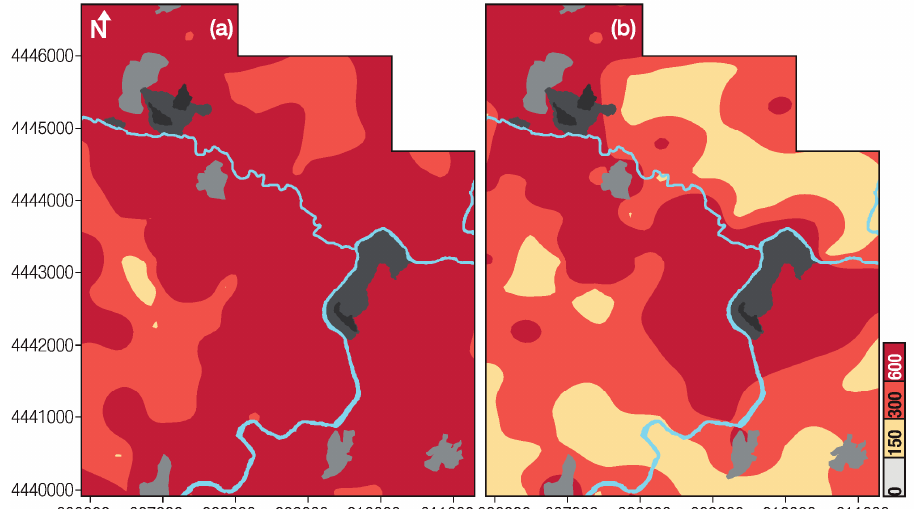
Figure 6. Spatial distribution of Potential Ecological Risk Index ( PERI ) for topsoil ( a ) and subsoil ( b ) in the study